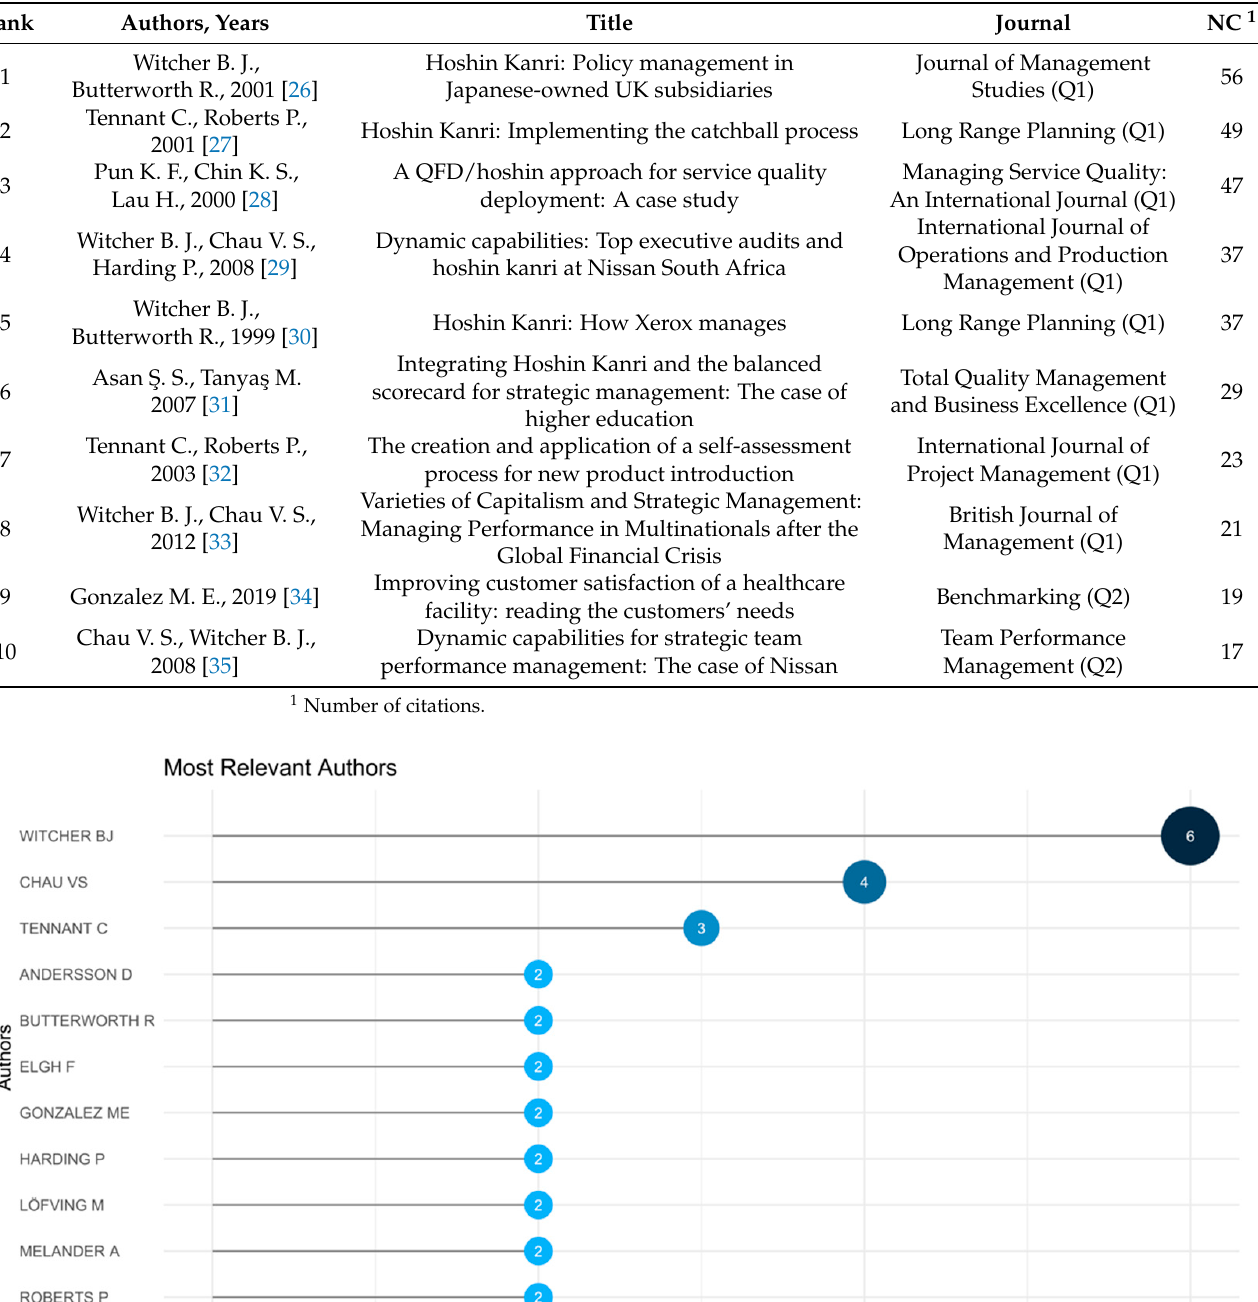
Table 4. The most cited articles.